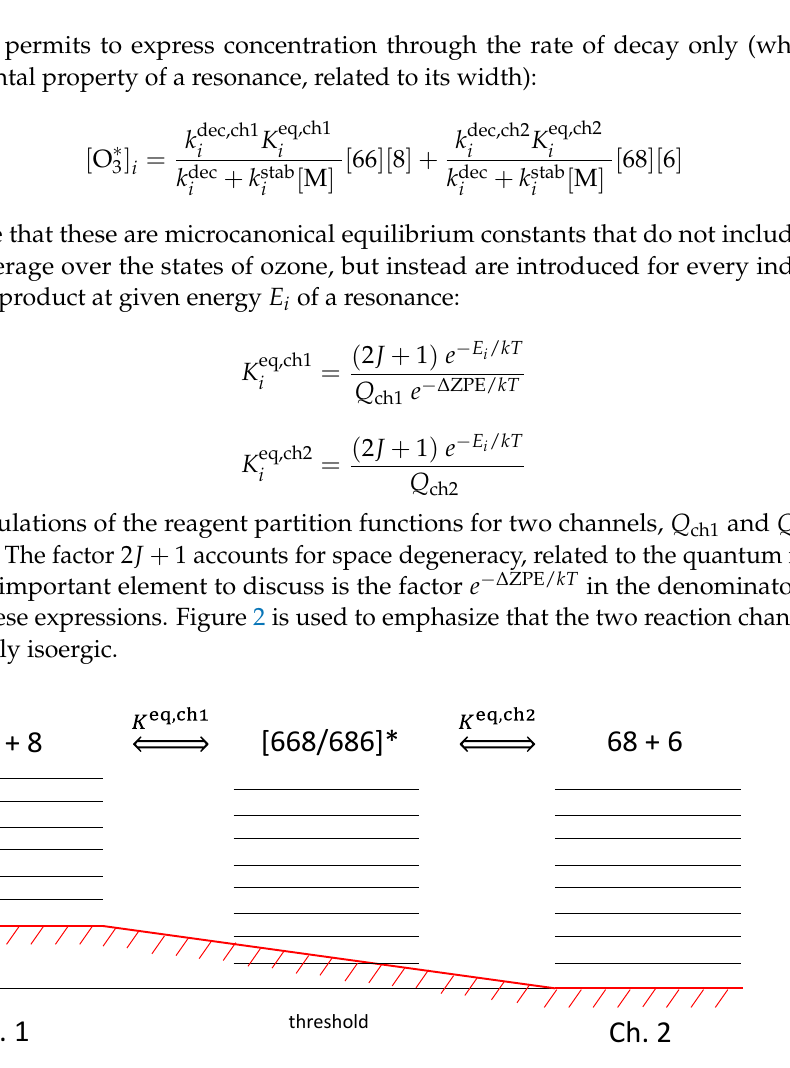
Figure 2. Two distinct channels of ozone formation (left and right) and the metastable ozone states (middle) in the case of single isotopic substitution. Here “6” denotes 16 O whereas “8” denotes 18 O. Lower energy channel corresponds to the heavier diatomic reagent 16 O 18 O with smaller zero-point energy. Upper channel corresponds to the lighter diatomic reagent 16 O 16 O. Energy difference of the two channels, ΔZPE, is indicated.